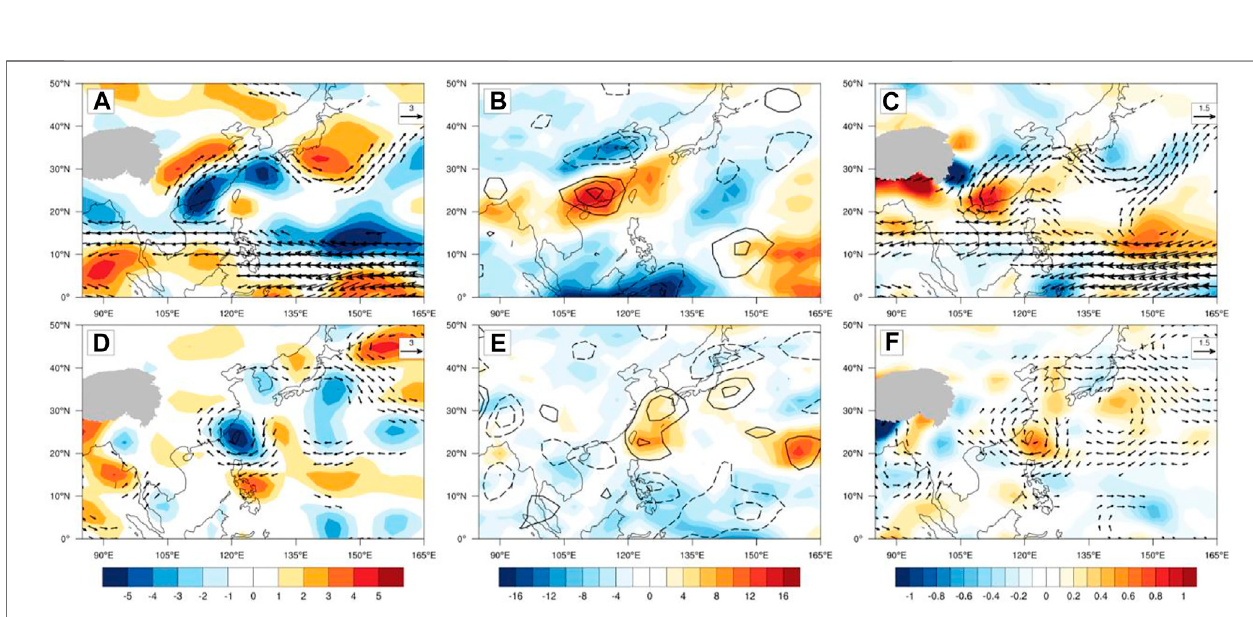
Frontiers in Earth Science |